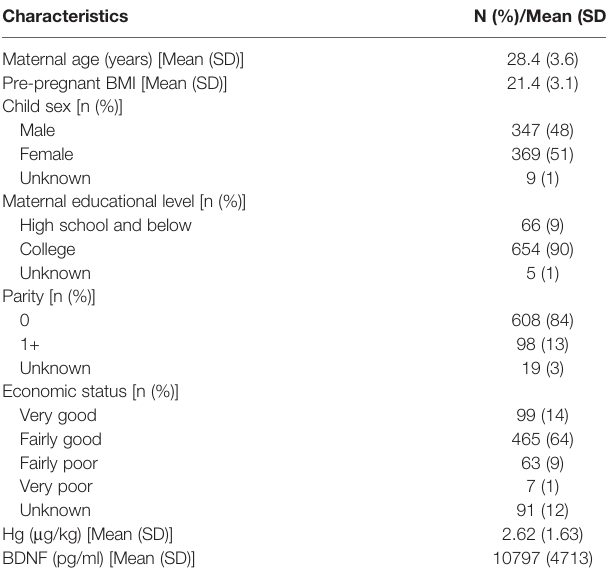
TABLE 1 | Demographic characteristics and BDNF levels in the Shanghai Birth